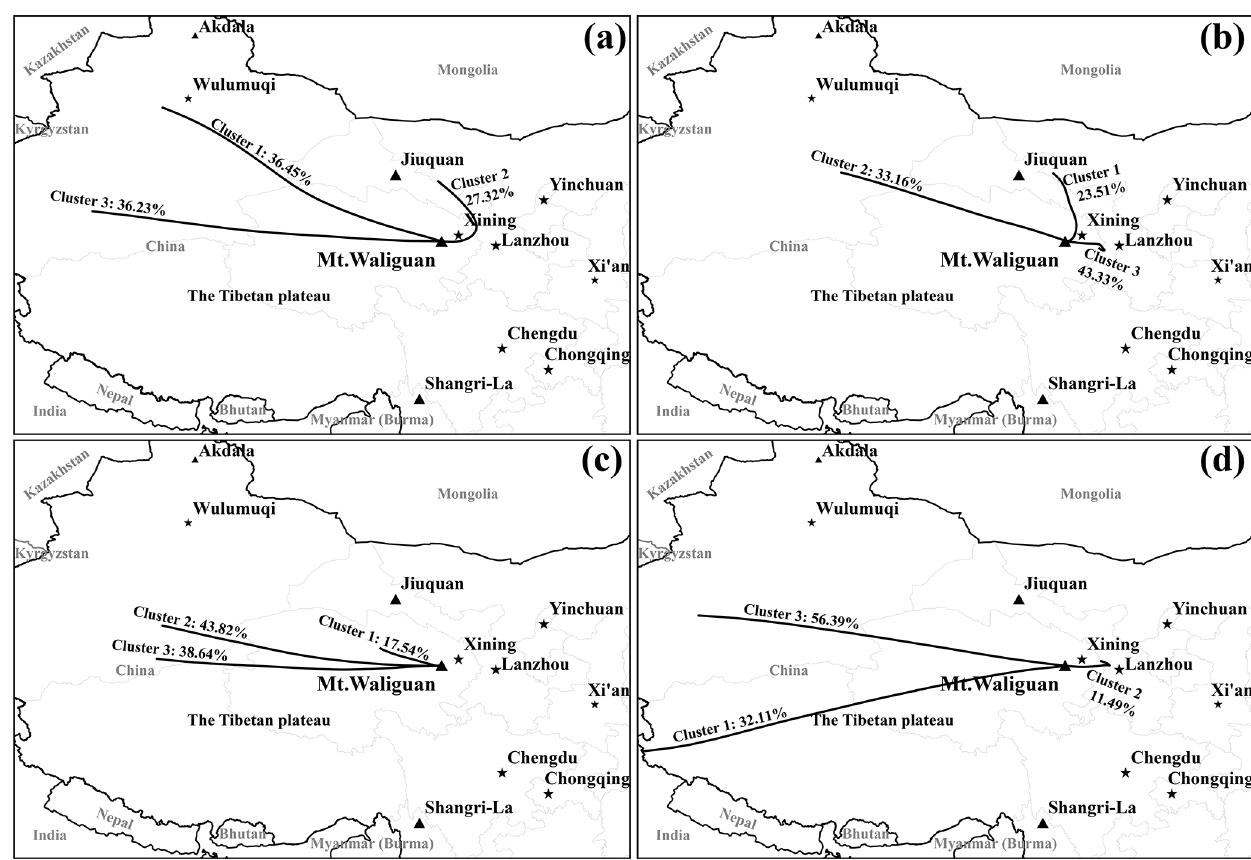
Figure 6. Cluster analysis of the 72h back trajectories in different seasons (spring – a ; summer – b ; autumn – c ; winter – d ) during 2004–2019 at the WLG station. The proportion of trajectories in each cluster is also